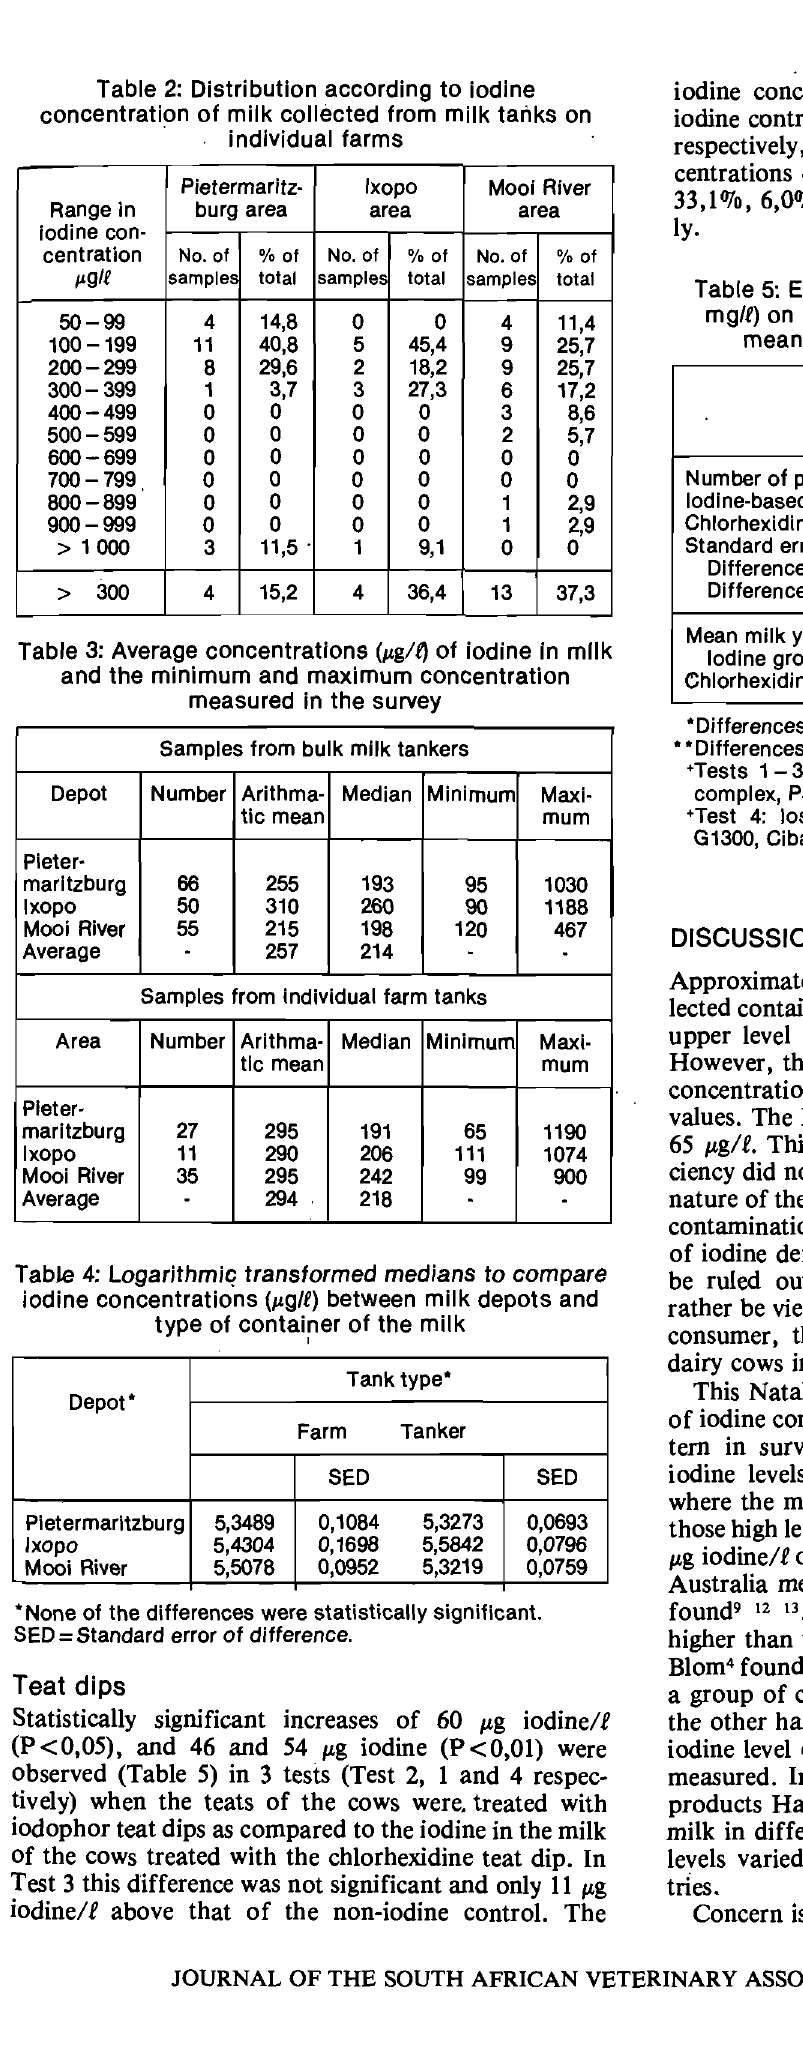
Table 2: Distribution according to iodine concentration of milk collected from milk tanks on .